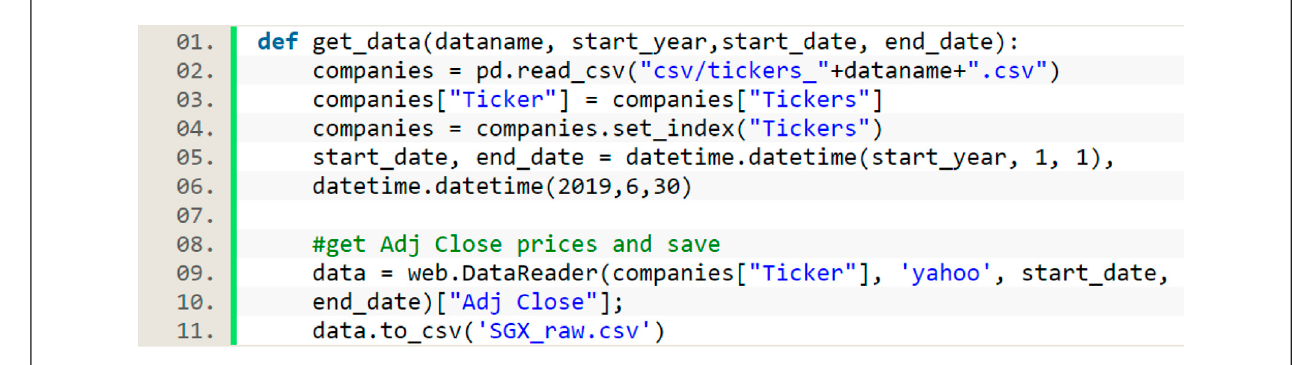
CODE 1. | A Python code that implements the data collection